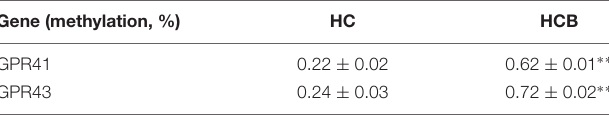
Frontiers in Physiology |